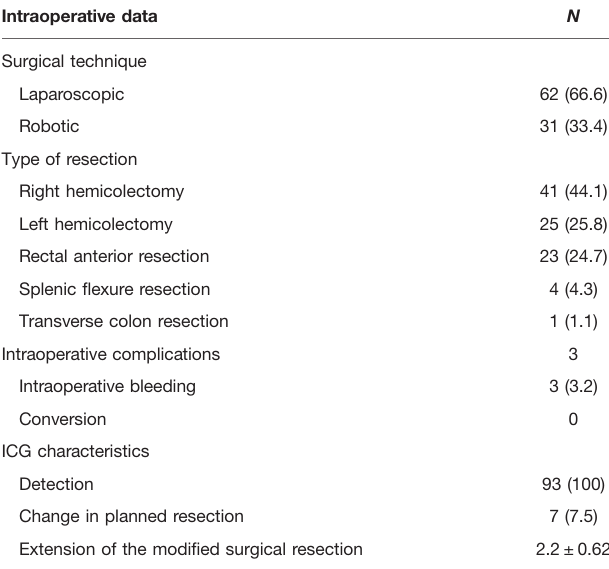
TABLE 2 | Intraoperative data.